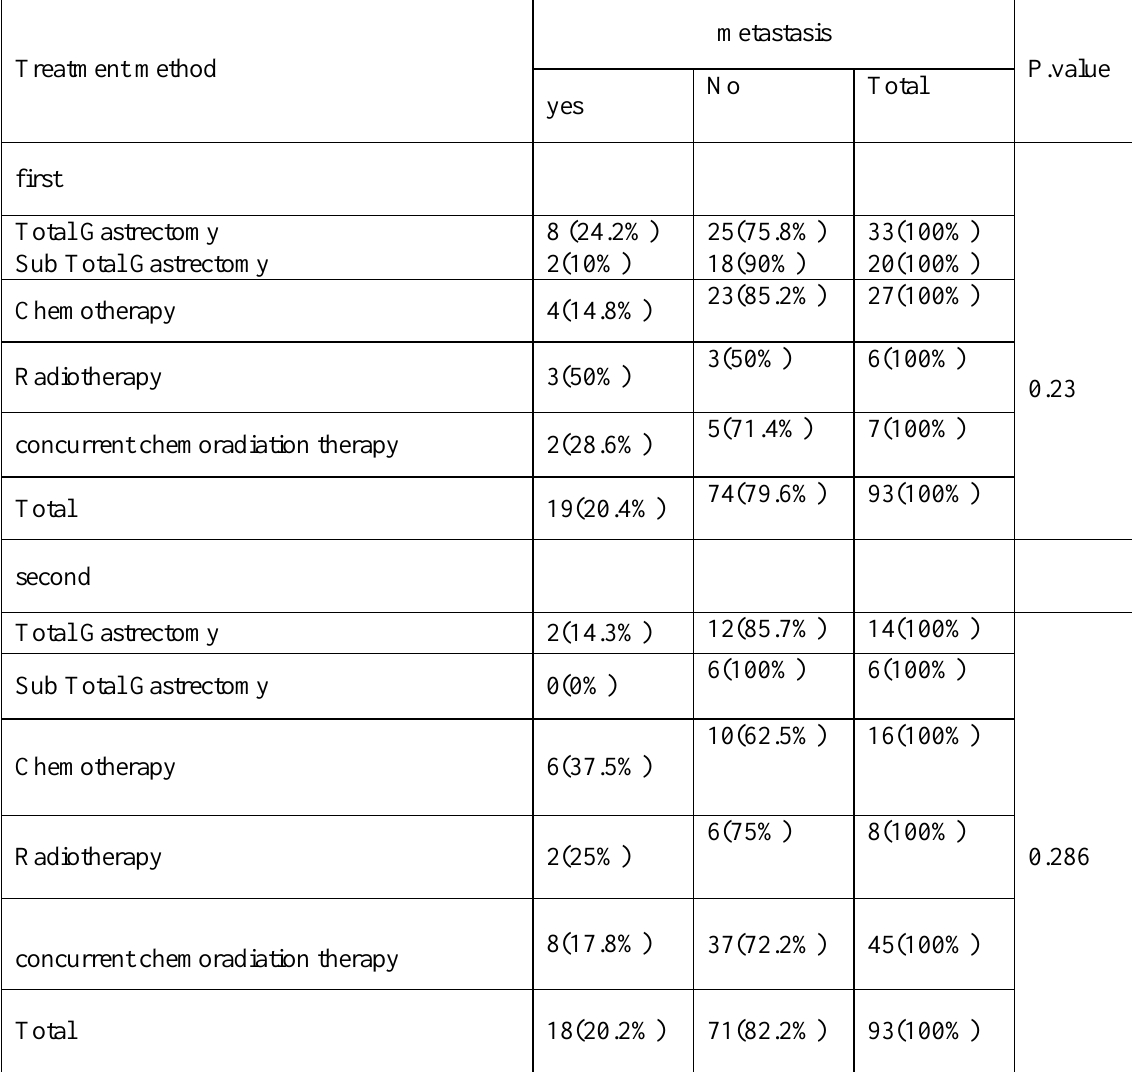
Table 2: distribution of metastasis based on the first and second treatment